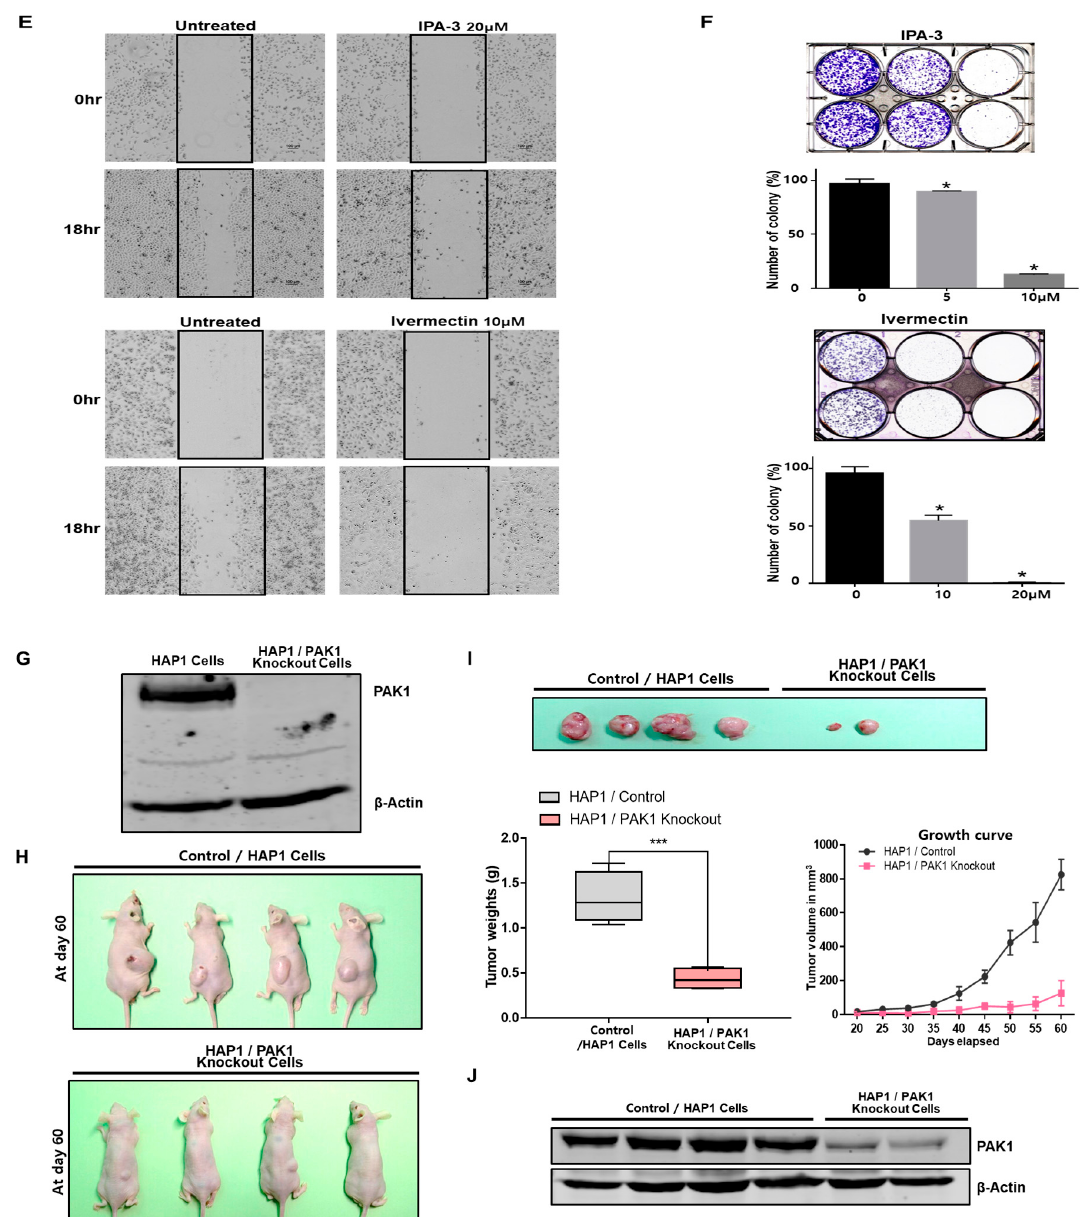
Figure 2. PAK1 inhibition blocks breast cancer hallmark processes. ( A , B ) Chemical structure of IPA-3 and ivermectin, and the effect of IPA-3 and ivermectin on the proliferation of breast cancer cells. Cancer cells were incubated with IPA-3 and ivermectin for 24 h. The antiproliferation effect of IPA-3 and ivermectin was determined by using an MTS (3-(4,5-dimethylthiazol-2-yl)-5-(3-carboxymethoxyphenyl)-2-(4-sulfophenyl)-2H-tetrazolium) assay. ( C ) Ivermectin induced apoptosis in cancer cells at the indicated concentration (20 μ M). Apoptotic cells were determined using Annexin V/PI staining. ( D ) The caspase3/7 activity of cancer cells was determined using a Caspase-Glo 3/7 assay kit (Promega). The data are presented as the mean ± standard deviation (SD); n = 3; * p < 0.05 vs. the control. ( E ) Effect of IPA-3 and ivermectin on cancer cell migration. The migration of cancer cells with or without IPA-3 and ivermectin was photographed at 0 and 18 h. ( F ) Effect of IPA-3 and ivermectin on colony formation. The one thousand dissociated cancer cells were incubated with IPA-3 and ivermectin for 1 week. Representative images were collected. The data are presented as the mean ± SD; n = 3; * p < 0.05 vs. control. ( G ) PAK1 expression was analyzed in wild-type and PAK1-knockout HAP1 cells by immunoblot using a PAK1-specific antibody. ( H , I ) Wild-type and PAK1- knockout HAP1 cell tumor growth in immunodeficient nude mice. The human PAK1-knockout HAP1